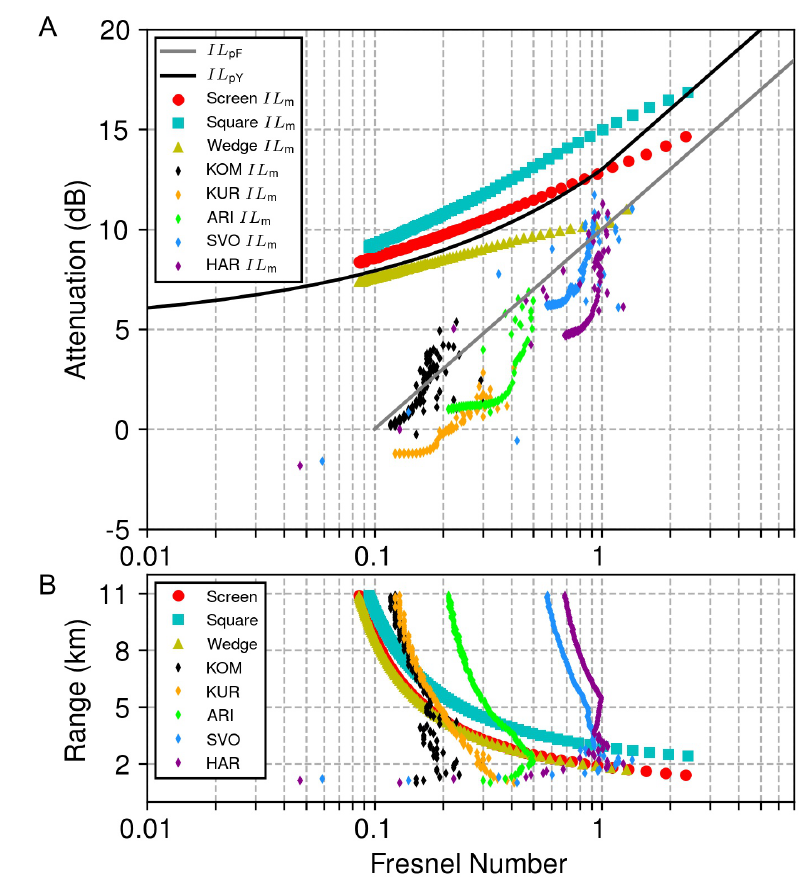
plitudes for the flat-ground approximations decay lin- early with distance from the source function receiver, as expected for spherical spreading (Figure 5A and 5B, respectively). When topography is included, the ampli- tudes are reduced at each station in the 2D case (Fig- ure 5A), whereas in the 3D case, the amplitudes are increased at ARI, KOM, and KUR (Figure 5B). These di ff erences are reflected in the IL m results (Figure 5C), which feature positive attenuation at every station in the 2D cases but only at HAR and SVO in the 3D cases. However, both modeling approaches produce the same relative amplitude and distribution across the network (e.g. ARI is always more attenuated than KUR and less attenuated than HAR). The attenuation predicted by IL pY is clearly greater than the IL m results from both 2D and 3D